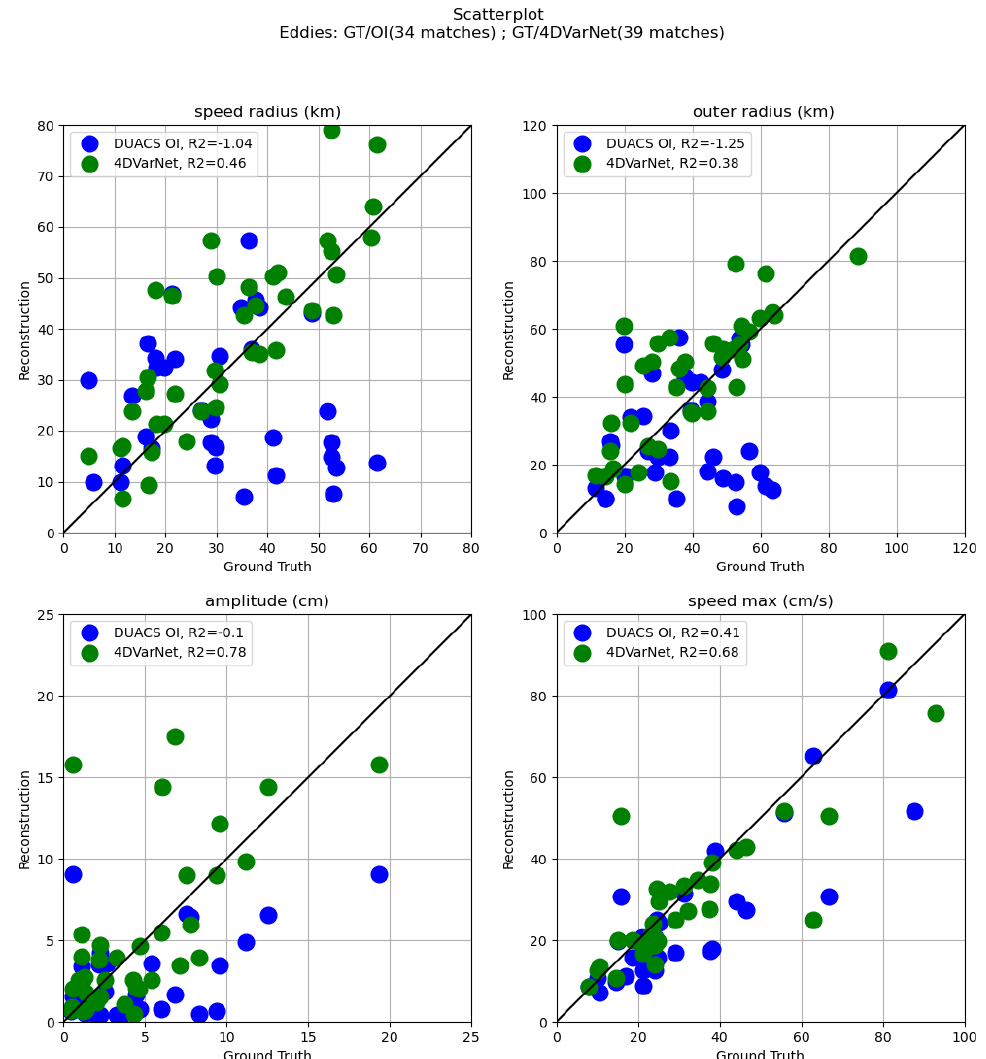
Figure C2. Speed radius (km), outer radius (km), amplitude (cm), and speed max (cms − 1 ) scatterplots of 4DVarNet/DUACS OI (four nadirs) vs. ground truth on the GULFSTREAM domain (25 October 2012) for matching